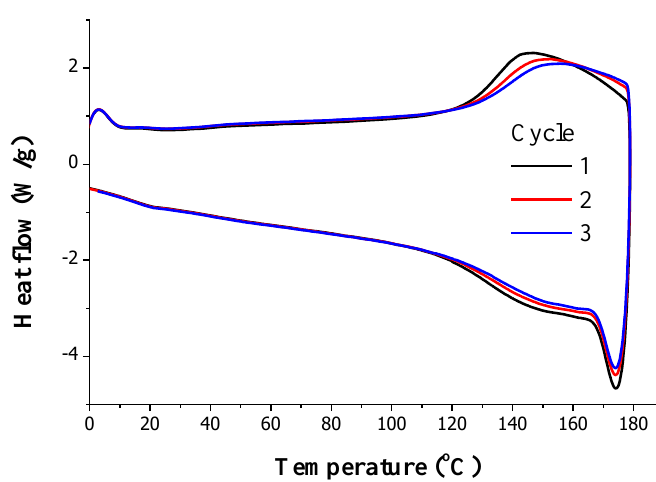
Figure 6. DSC thermal cycles of PK-Fu crosslinked with B-Ma and reinforced with MWCNTs.